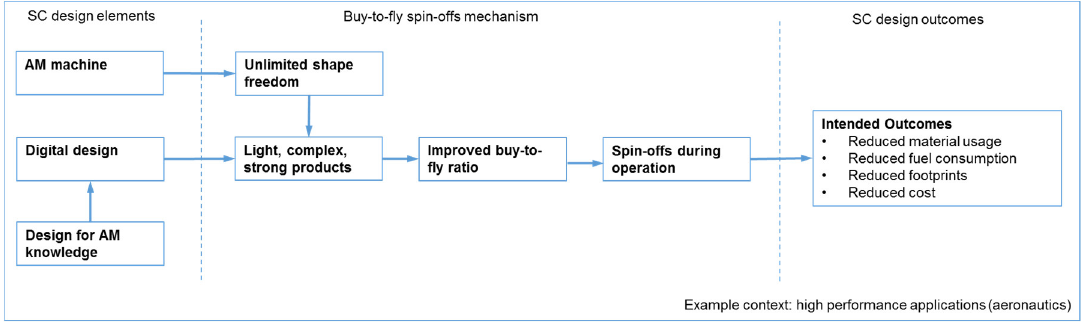
Figure 6. Buy-to-fly spin-offs mechanism.